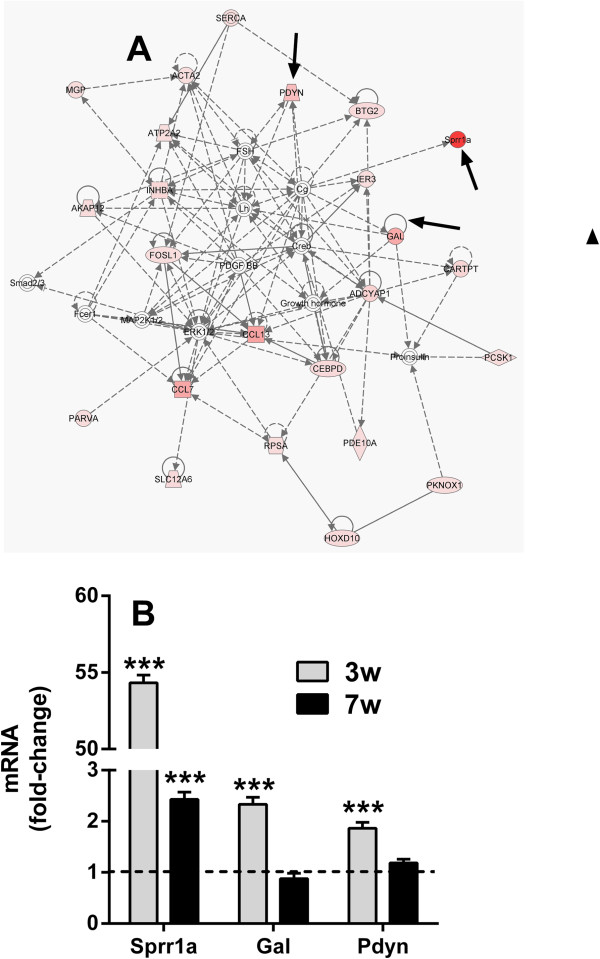
Transcriptional pathway analysis and validation of transcript mRNA expression. IPA identified interacting networks affecting cell signaling. Up-regulated transcripts are marked with red (A). SPRR1a, GAL, and PDYN transcripts were validated by quantitative PCR. The dotted line indicates control measures (B). *** p<0.001. n=4/group. Errors bars=S.E.M.